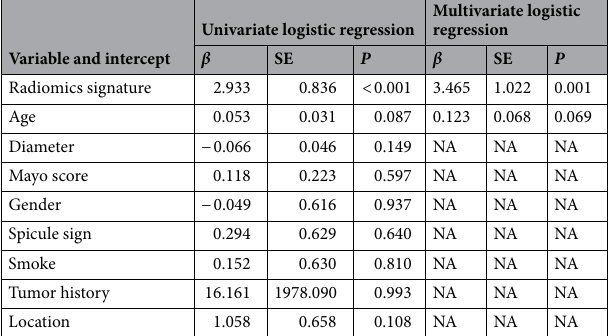
Table 2. Risk factors for malignant in lung nodule.